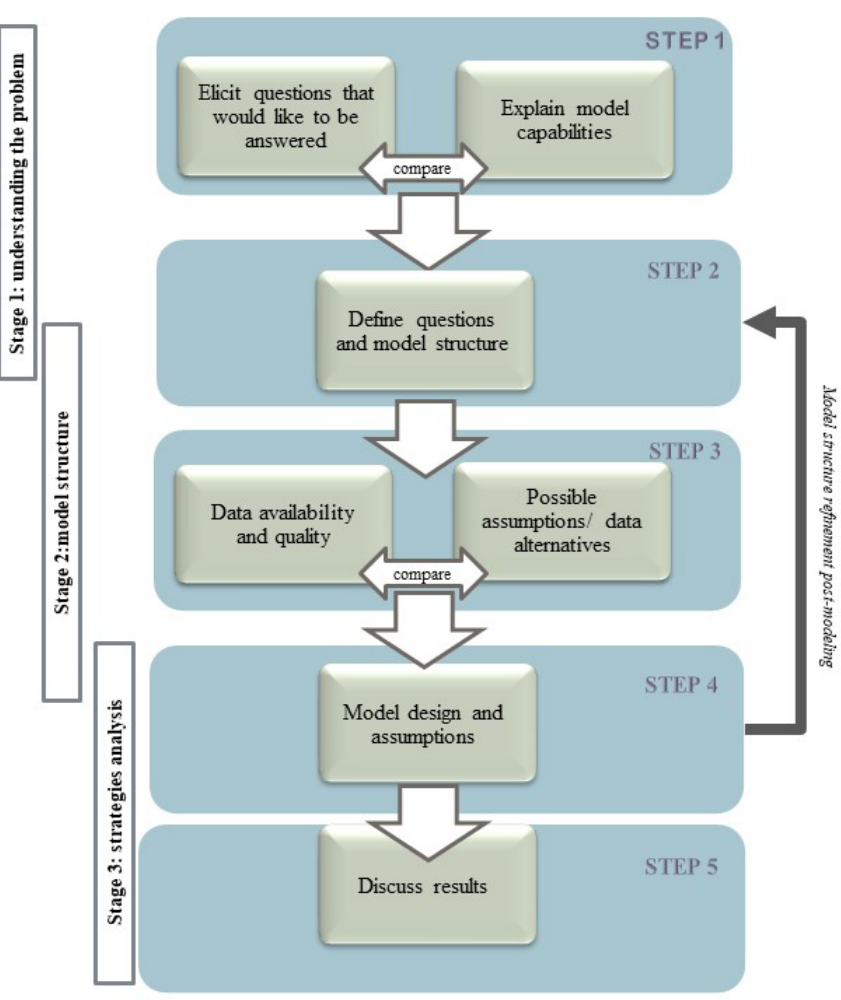
Figure 2. Main steps that guided the participatory modeling process. On the left there is a comparison with the questions/comments interac- tion stages presented in Fig.